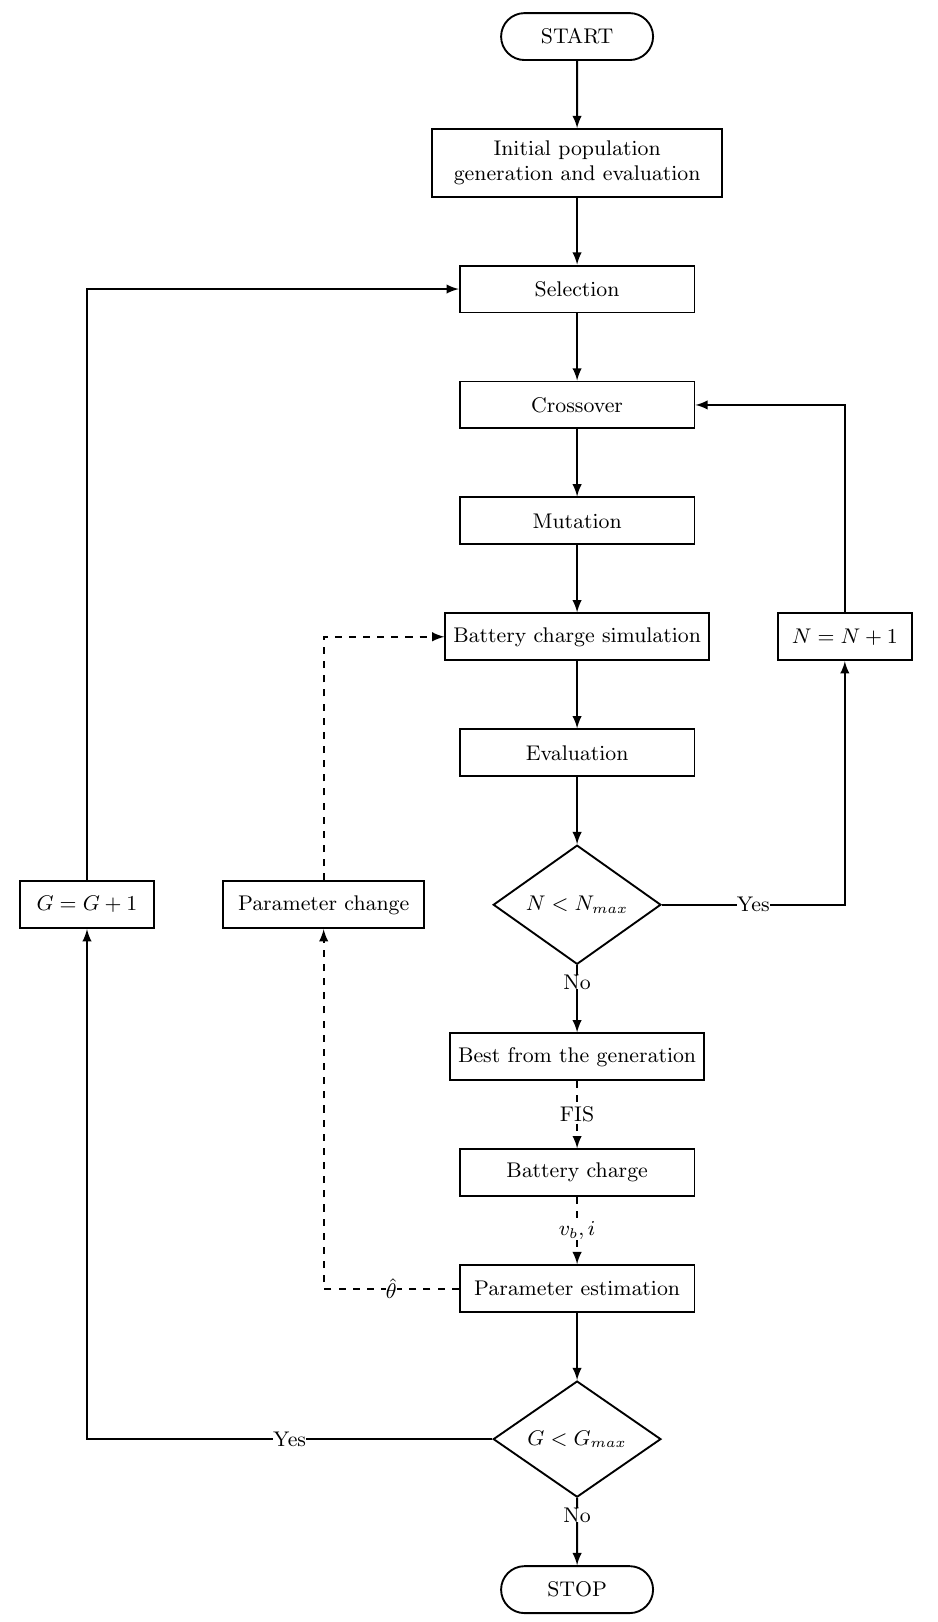
Figure 4. Flowchart of the system: N stands for the number of individuals of the current generation. G means the number of the actual generation, while G max is the maximal number of